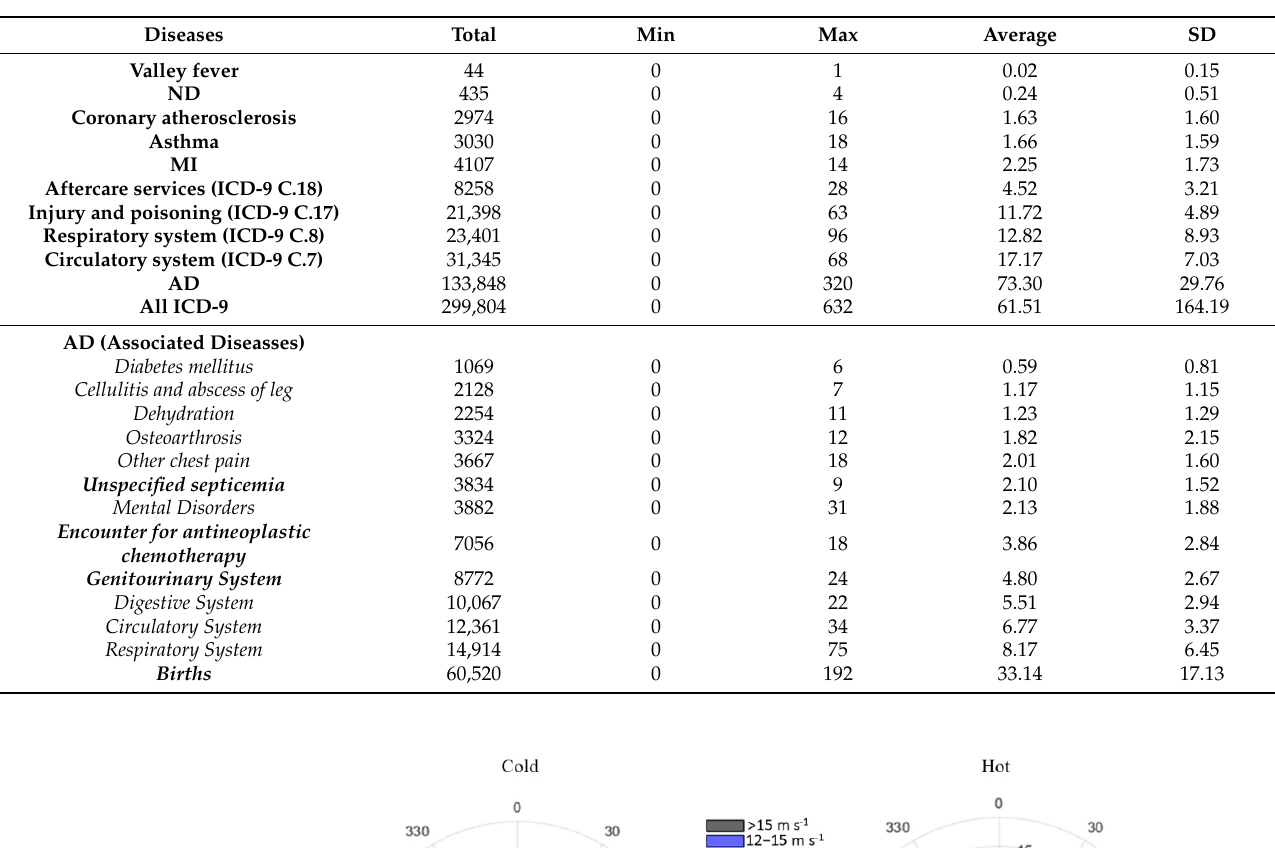
Table 1. Descriptive analysis of disease categories and associated hospitalizations. El Paso County, TX, 2010–2014. Categories in bold were found by the analyses to have some significant association with specified increases in PM 10 concentration and/or wind speed at some lag between 0 and 7 days. Categories in italics are part of AD; those in bold were individually significant.